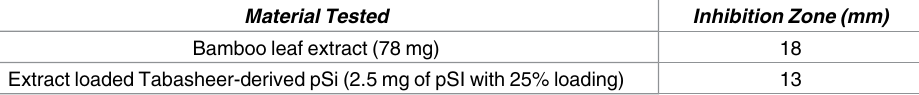
Table 1. Antibacterial activity (against S . aureus) of bamboo extract and extract-loaded pSi after 24 h incubation period (at